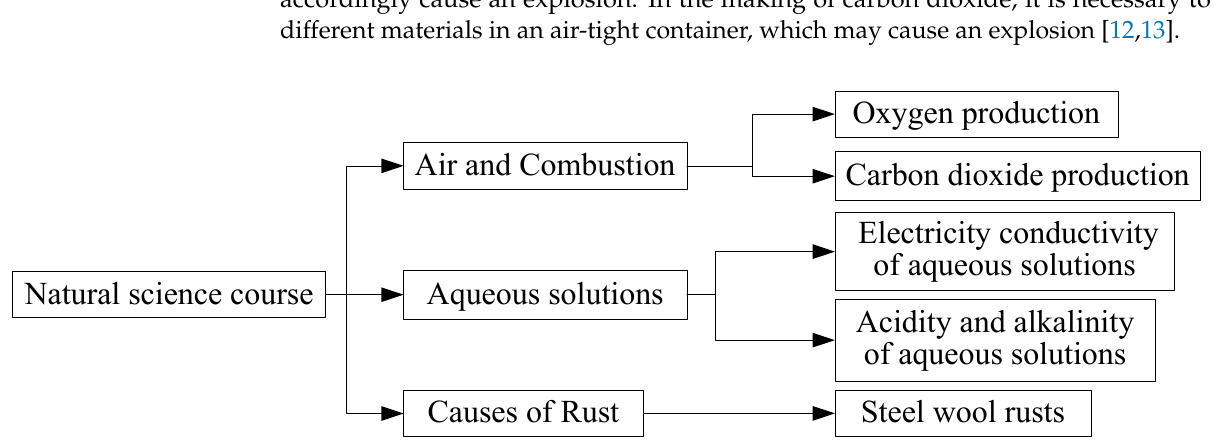
Figure 2. Knowledge framework of related concepts in natural science courses.